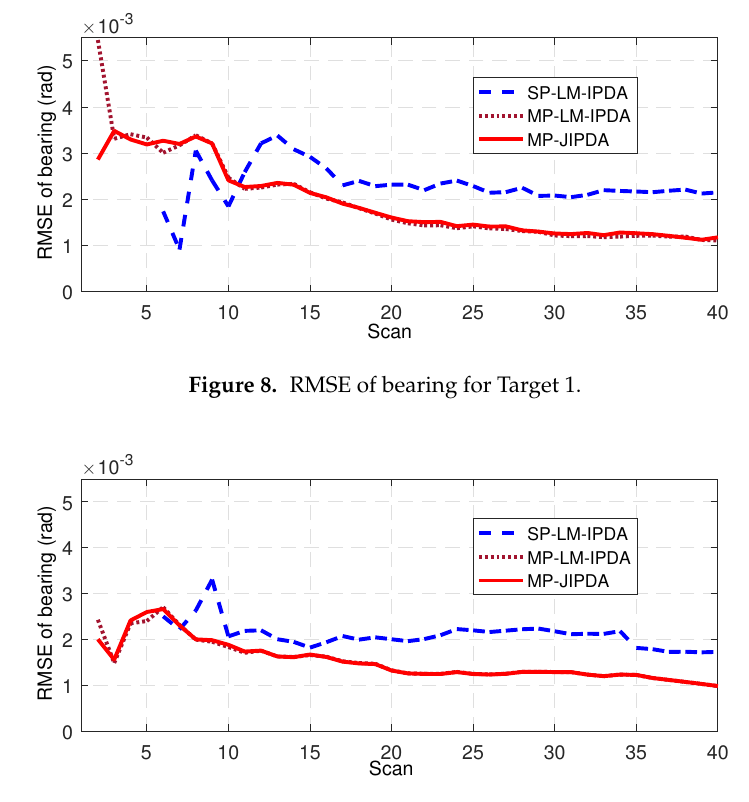
Figure 9. RMSE of bearing for Target